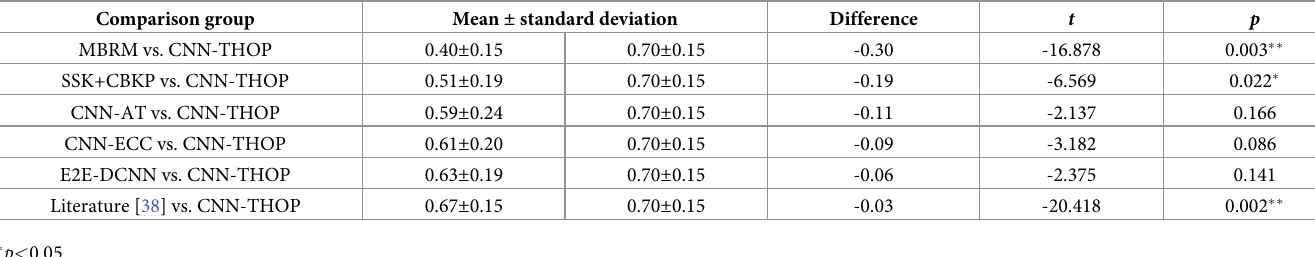
Table 6. Comparison of the precision of different methods over three datasets according to pairwise t -tests. Comparison